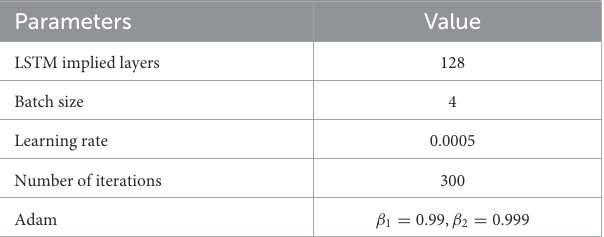
TABLE 4 Parameter setting after optimization